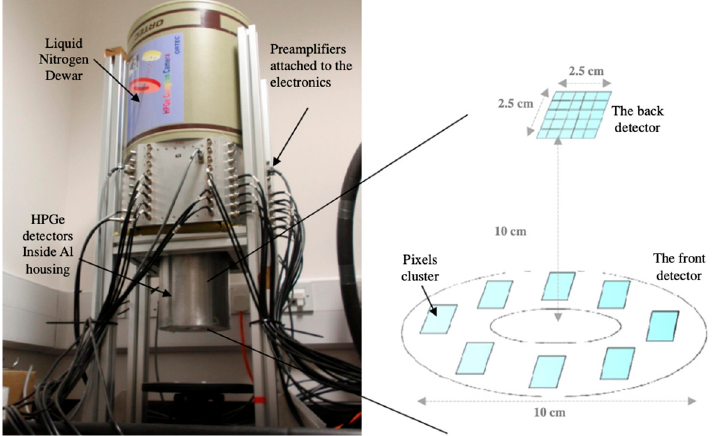
Figure 4. Pixelated HPGe Compton camera with the detector configurations [109]. Reprinted with permissions from Alnaaimi et al. [109].